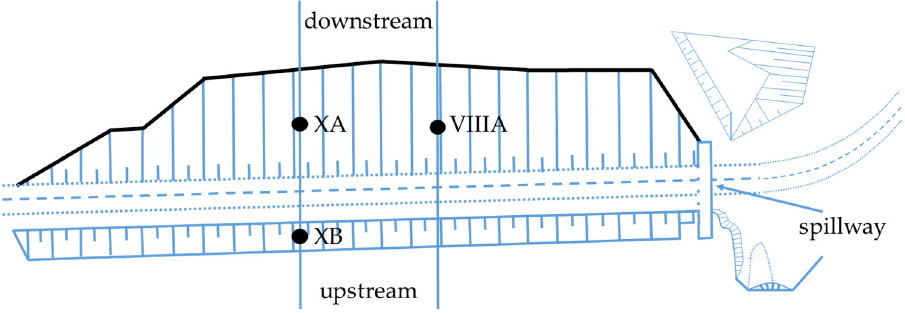
Figure 4. The embankment dam at the Koszyce site,•